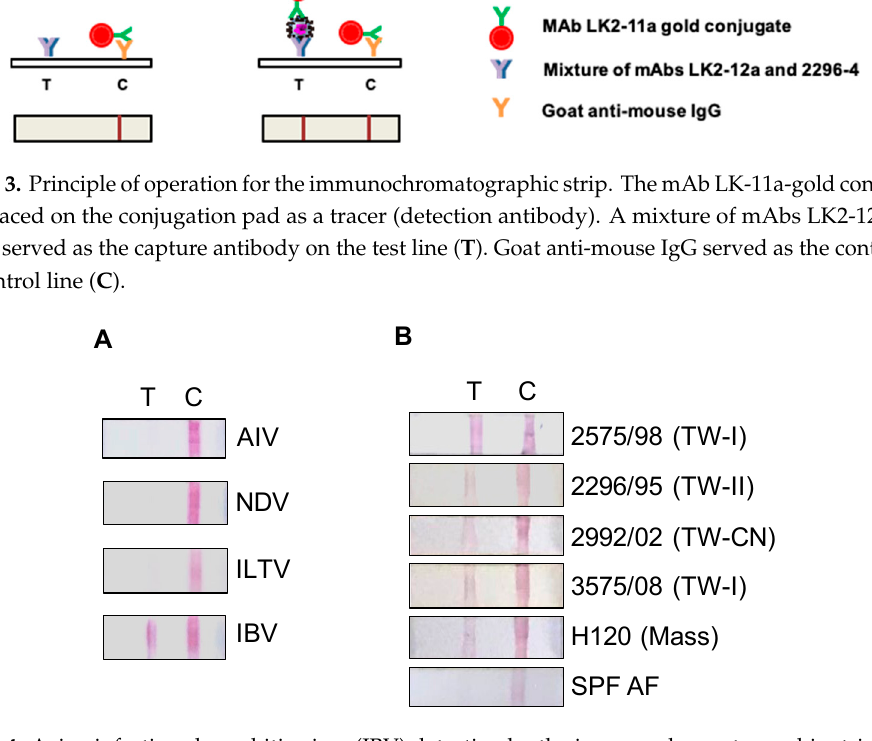
Figure 4. Avian infectious bronchitis virus (IBV) detection by the immunochromatographic strip (ICS). ( A ) Allantoic fluid (AF) of avian respiratory pathogens, avian influenza virus (AIV), Newcastle disease virus (NDV), infectious laryngotracheitis virus (ILTV) and infectious bronchitis virus (IBV) were tested with the ICS; ( B ) various IBV strains including 2575 / 98 (TW-I), 2296 / 95 (TW-II), 2992 / 02 (TW-China variant), 3575 / 08 (TW-I), H120 (Mass), and AF from specific-pathogen-free (SPF) chicken embryos were examined using the ICS. T: Test line; C: Control line. Table 1 . Detection limit for various IBV strains by immunochromatographic strip.